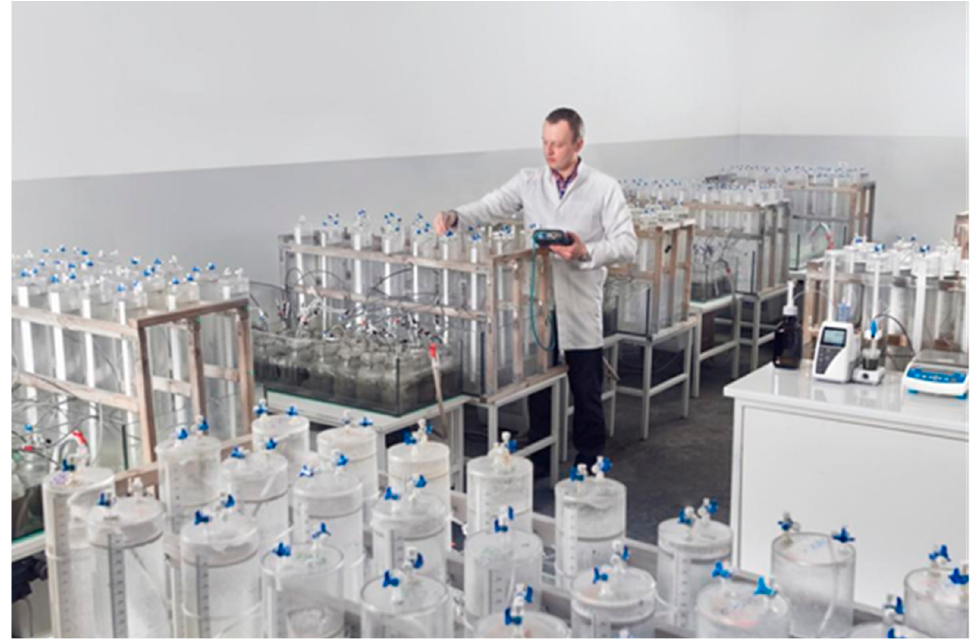
Figure 5. View of batch culture test stands (designed and created by employees of the Ecotechnology Laboratory).